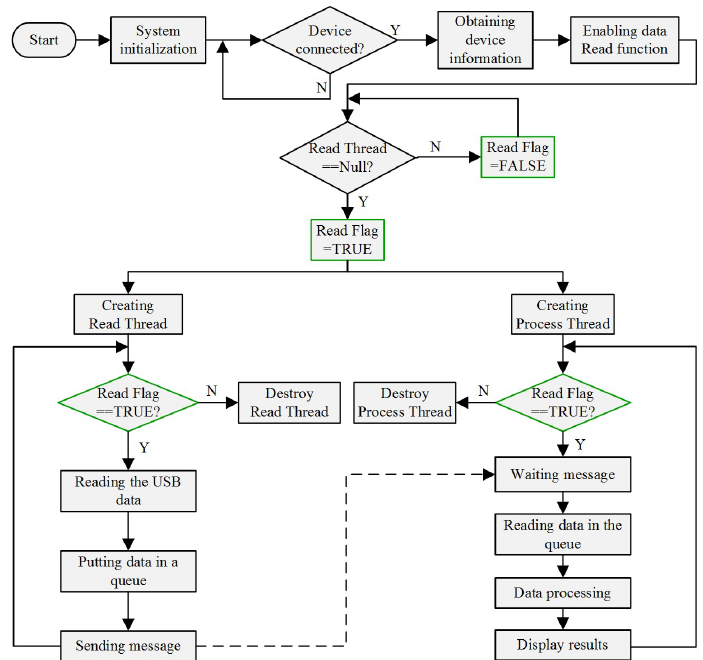
Figure 3. Software flow chart of real-time vibration detection based on MFC.